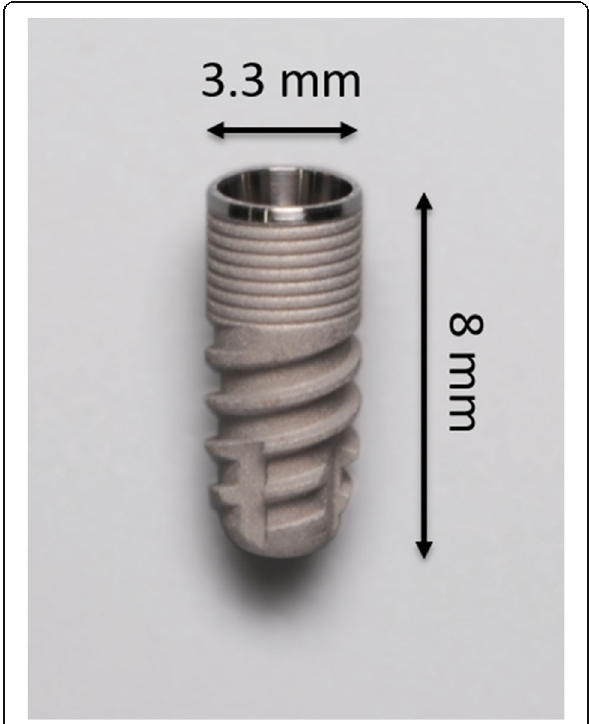
Fig. 2 GC Aadva ® implant; 3.3-mm diameter, 8-mm length